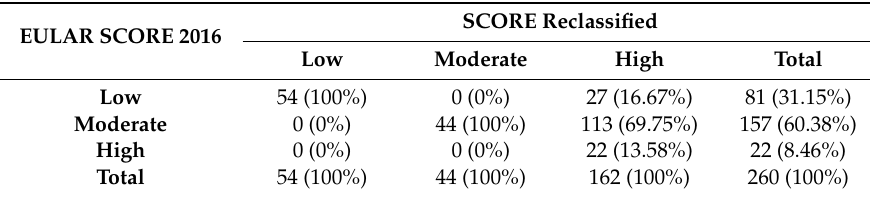
Table 3. Relationship between original EULAR SCORE 2016 and SCORE reclassified by the carotid US assessment.